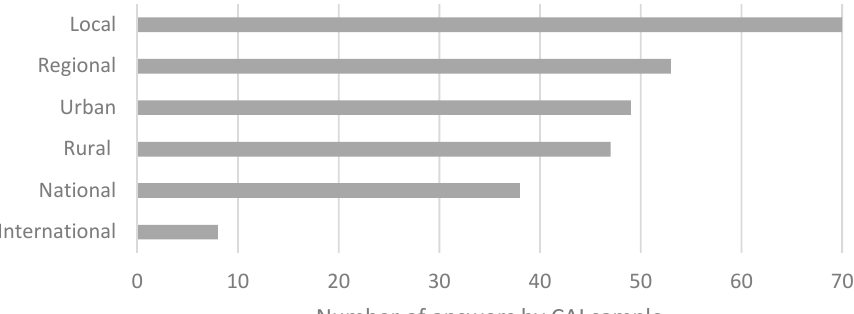
Figure 2. Overall geographical scope.